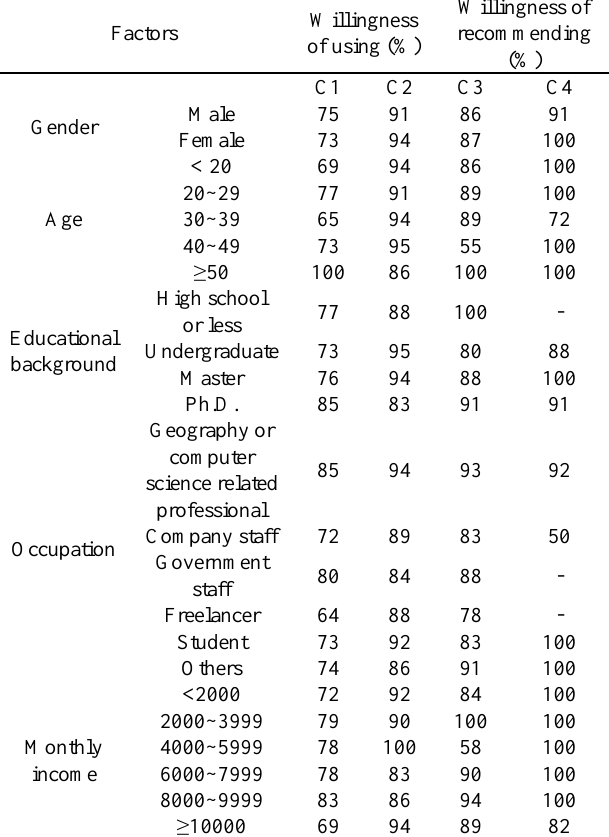
Table 1. Cross effects of some factors on willingness to use